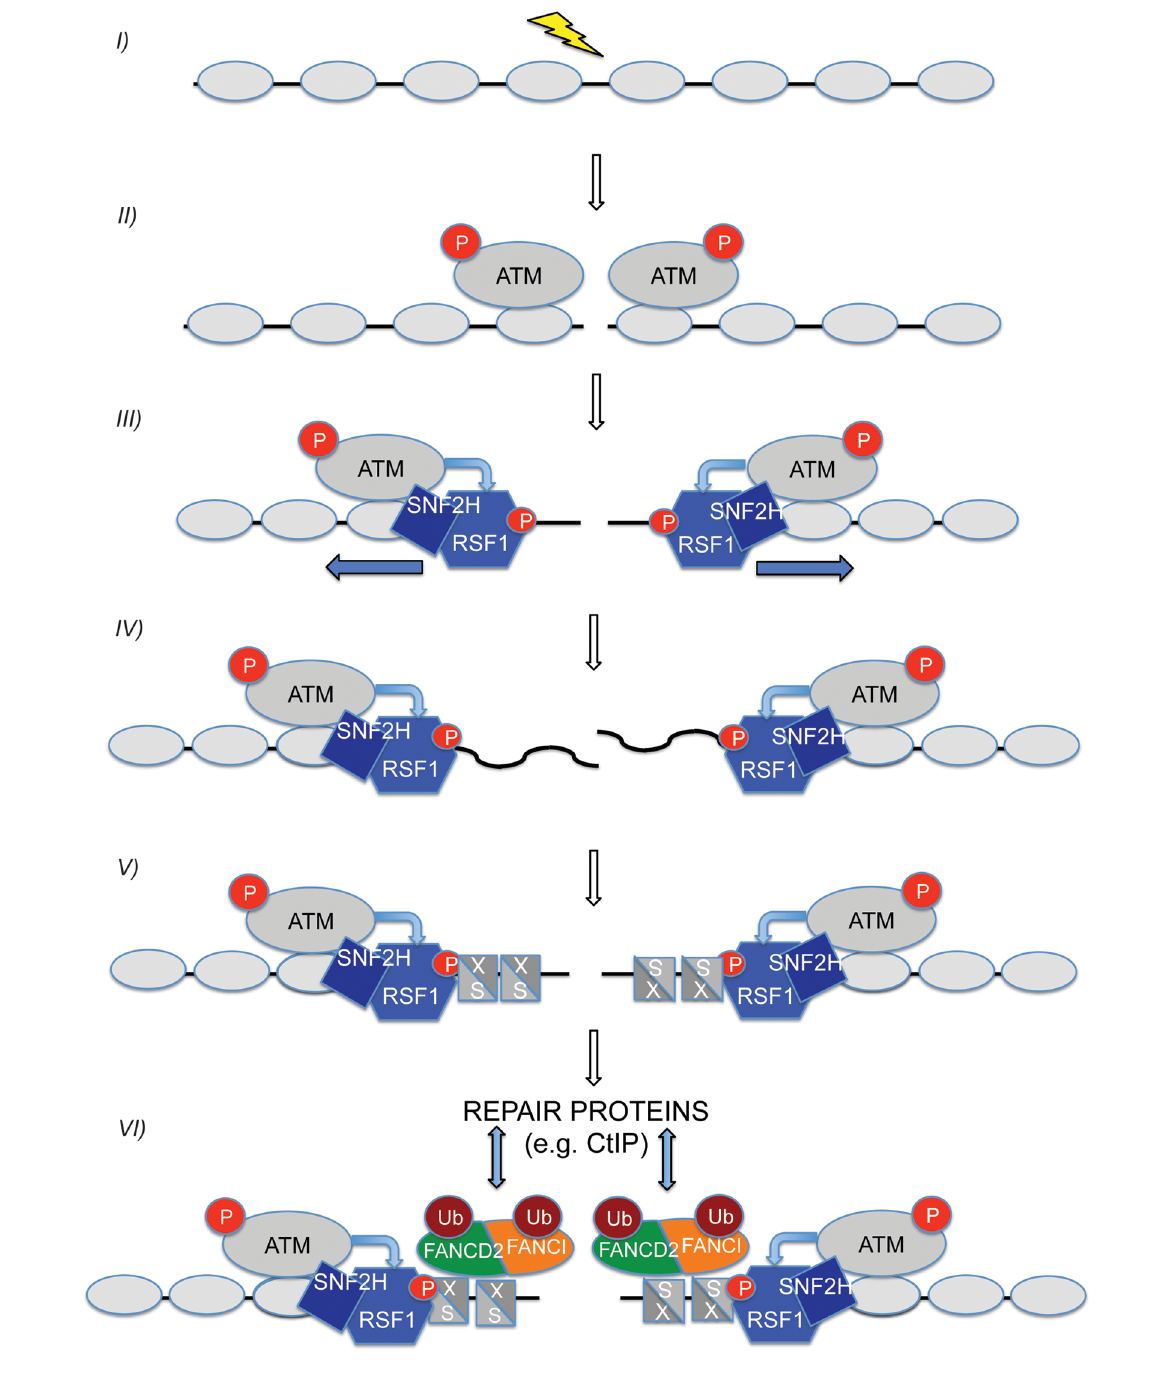
Figure 7. ATM-dependent activation of the RSF complex facilitates DNA DSB repair. Upon damage (step I) ATM is activated and recruited to chromatin containing a DSB (step II). One of the substrates of ATM is the RSF1 protein. Once activated by ATM-dependent phosphorylation of RSF1 (step III), we propose that the RSF chromatin-remodelling complex facilitates DSB repair utilising its translocase activity, via an ill-understood mechanism likely to involve nucleosome sliding (step III) and even nucleosome clearance (step IV). As part of this process, CENPS/MHF1 and CENPX/ MHF2, two histone-fold proteins, are recruited to the vicinity of the DSB in an RSF-dependent fashion (step V). As the CENPS/MHF1–CENPX/MHF2 tetramer has fewer contacts with DNA than a nucleosome or the H3–H4 tetramer [25], it could perform a ‘‘ placeholder ’’ function, preventing DNA that has been unwound from nucleosomes on either side of the DSB from forming a random coil and also facilitating the subsequent access of DSB repair machineries. Downstream of CENPS/MHF1 and CENPX/MHF2 recruitment, the FANCD2 and FANCI proteins are recruited and mono-ubiquitinated by a mechanism dependent upon prior recruitment of CENPS/MHF1 and CENPX/MHF2 (step 6). It is not know how many steps exist between CENPS/ MHF1–CENPX/MHF2 and subsequent FANCD2–FANCI recruitment. Mono-ubiquitinated FANCD2 and FANCI presumably functions as docking sites that regulate recruitment of subsequent DSB repair proteins, such as CtIP, which has functions in both NHEJ and HR.